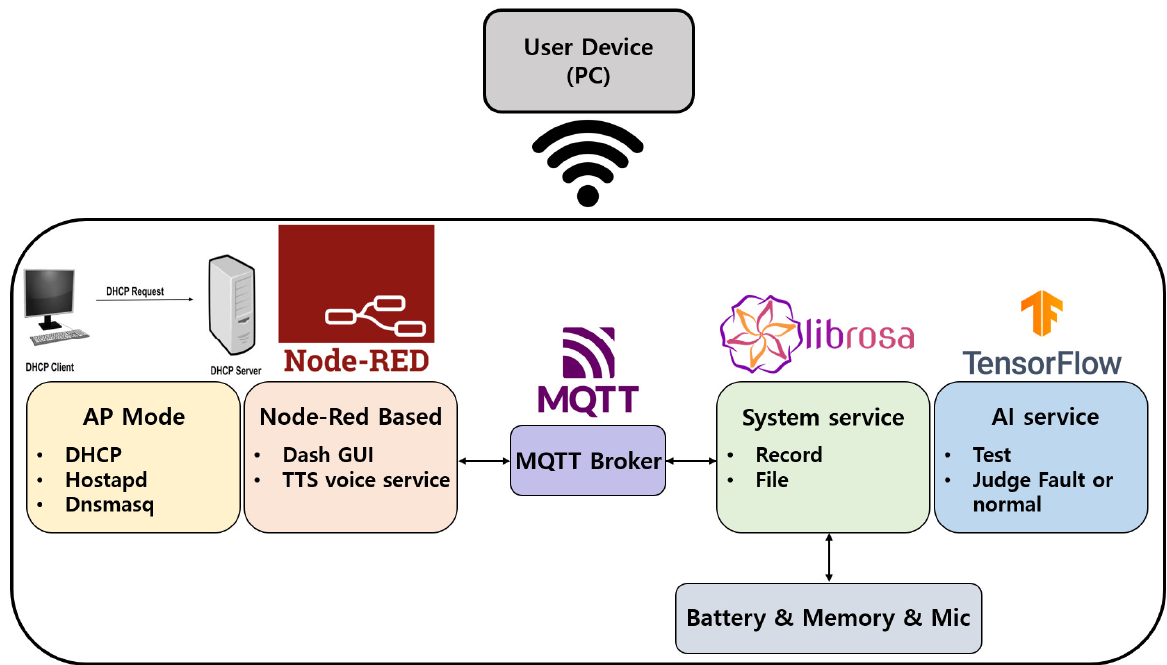
Figure 11. Internal structure of embedded system devices as: ( a ) embedded system internal struc- ture; ( b ) embedded system internal equipment.